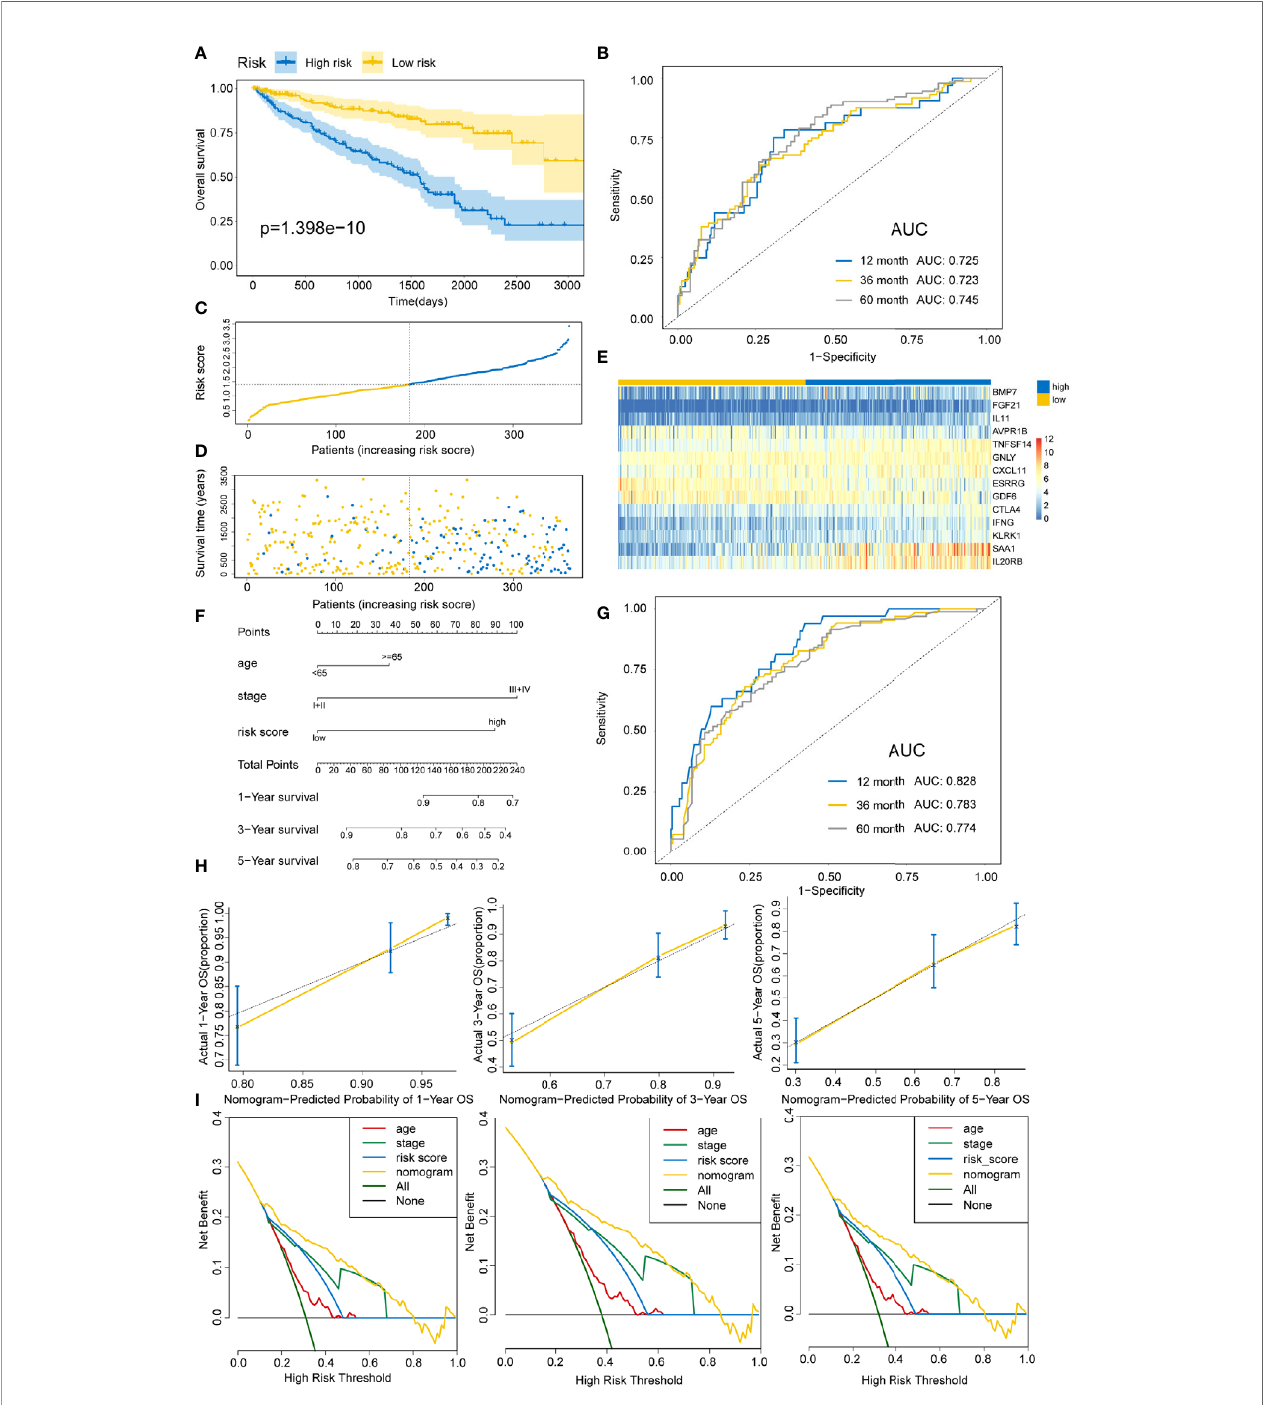
FIGURE 4 | Constructing an immune risk score predictive model using the training set. (A) Kaplan – Meier curves for OS outcomes in the training cohort grouped into high- and low-risk score groups. (B) Time-dependent ROC curves for prediction of 1-, 3-, and 5-year survival outcomes. (C) Distribution of risk scores of the training cohort. (D) Vital statuses for patients in high- and low-risk patients. (E) Expression patterns for 14 immune-associated genes in high- and low-risk score cohorts. (F) A nomogram for the estimation of 1-, 3-, and 5-year OS probabilities in the training cohort. Risk scores and other independent prognostic factors are incorporated in the model. (G) Time-dependent ROC curves for the prediction of 1-, 3-, and 5-year survival rates using the nomogram. (H) Calibration plot of nomogram in the training cohort according to the agreement between predicted and observed 1-, 3-, and 5-year outcomes. The model ’ s ideal performance is shown by dashed lines. (I) Decision curve analysis for 1-, 3-, and 5-year risk using the nomogram. Black line represents the hypothesis that no patient died at 1-, 3-, and